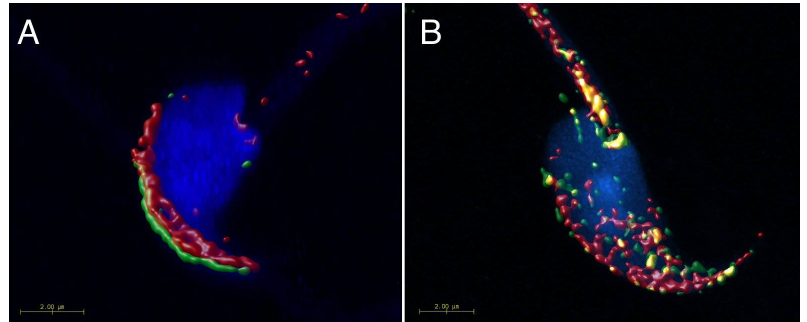
Figure 3. Surface rendering of colocalization map of CD9 and CD81 in mouse epididymal and acrosome reacted sperm. Confocal images and Huygens software were used for better visualisation colocalization area (yellow) of CD9 (red) and CD81 (green). ( A ) No colocalization area was detected on freshly released epididymal sperm contrary to the acrosome reacted sperm ( B ), where the analysis confirmed a mutual colocalization of CD9 and CD81. Colocalization maps are based on Pearson’s correlation coefficient. DAPI (blue) Scale bar represents 2 μm.